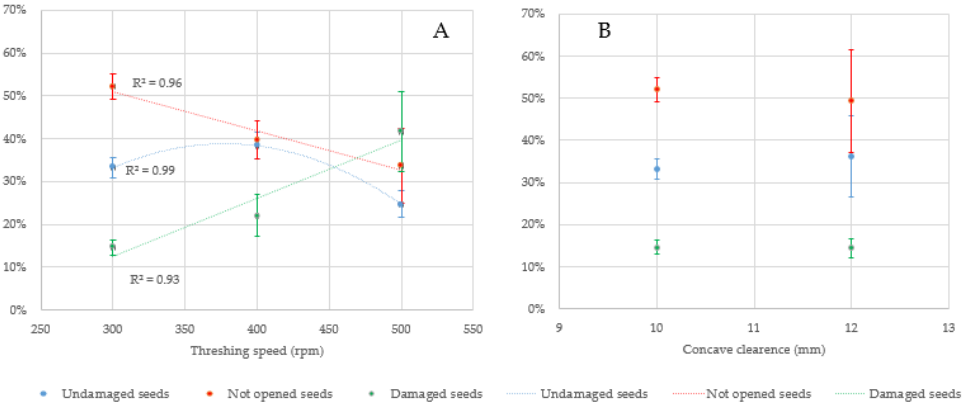
Figure 2. Percentage of undamaged, not opened and damaged seeds in relation to the rotational speed of the thrashing drum ( A ) and the clearance ( B ).